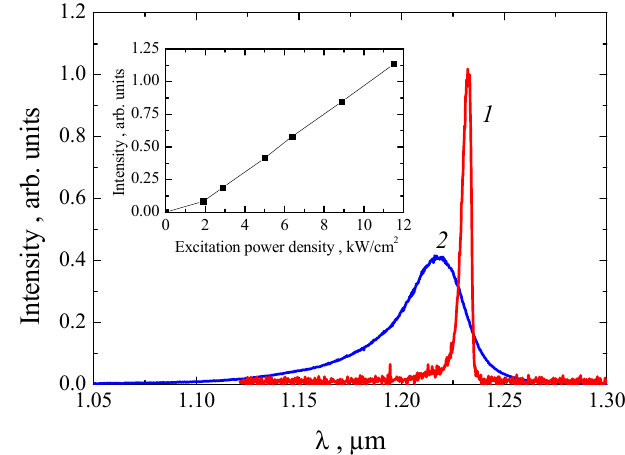
Figure 13. Spectrum of stimulated emission of the structure with the strained In 0.46 Ga 0.54 As/GaAs QW grown on a GaAs substrate ( 1 ). For comparison, the spectrum of spontaneous emission is shown (not to scale) ( 2 ). The pumping power densities are 5 kW/cm 2 and 5 W/cm 2 for ( 1 ) and ( 2 ), respectively. The measurement temperature is T = 300 K. Dependence of the integral emission intensity on the excitation power density is shown in the inset.